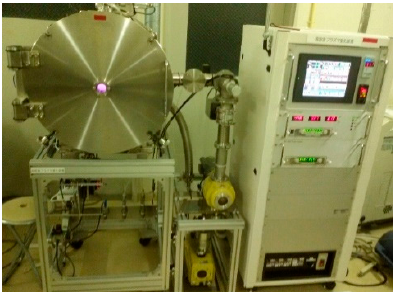
Figure 4. Appearance of the plasma nitriding machine.